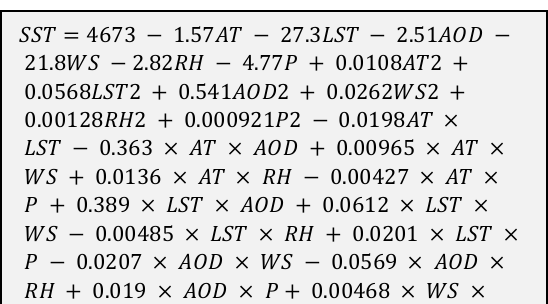
Figure 9. SST model